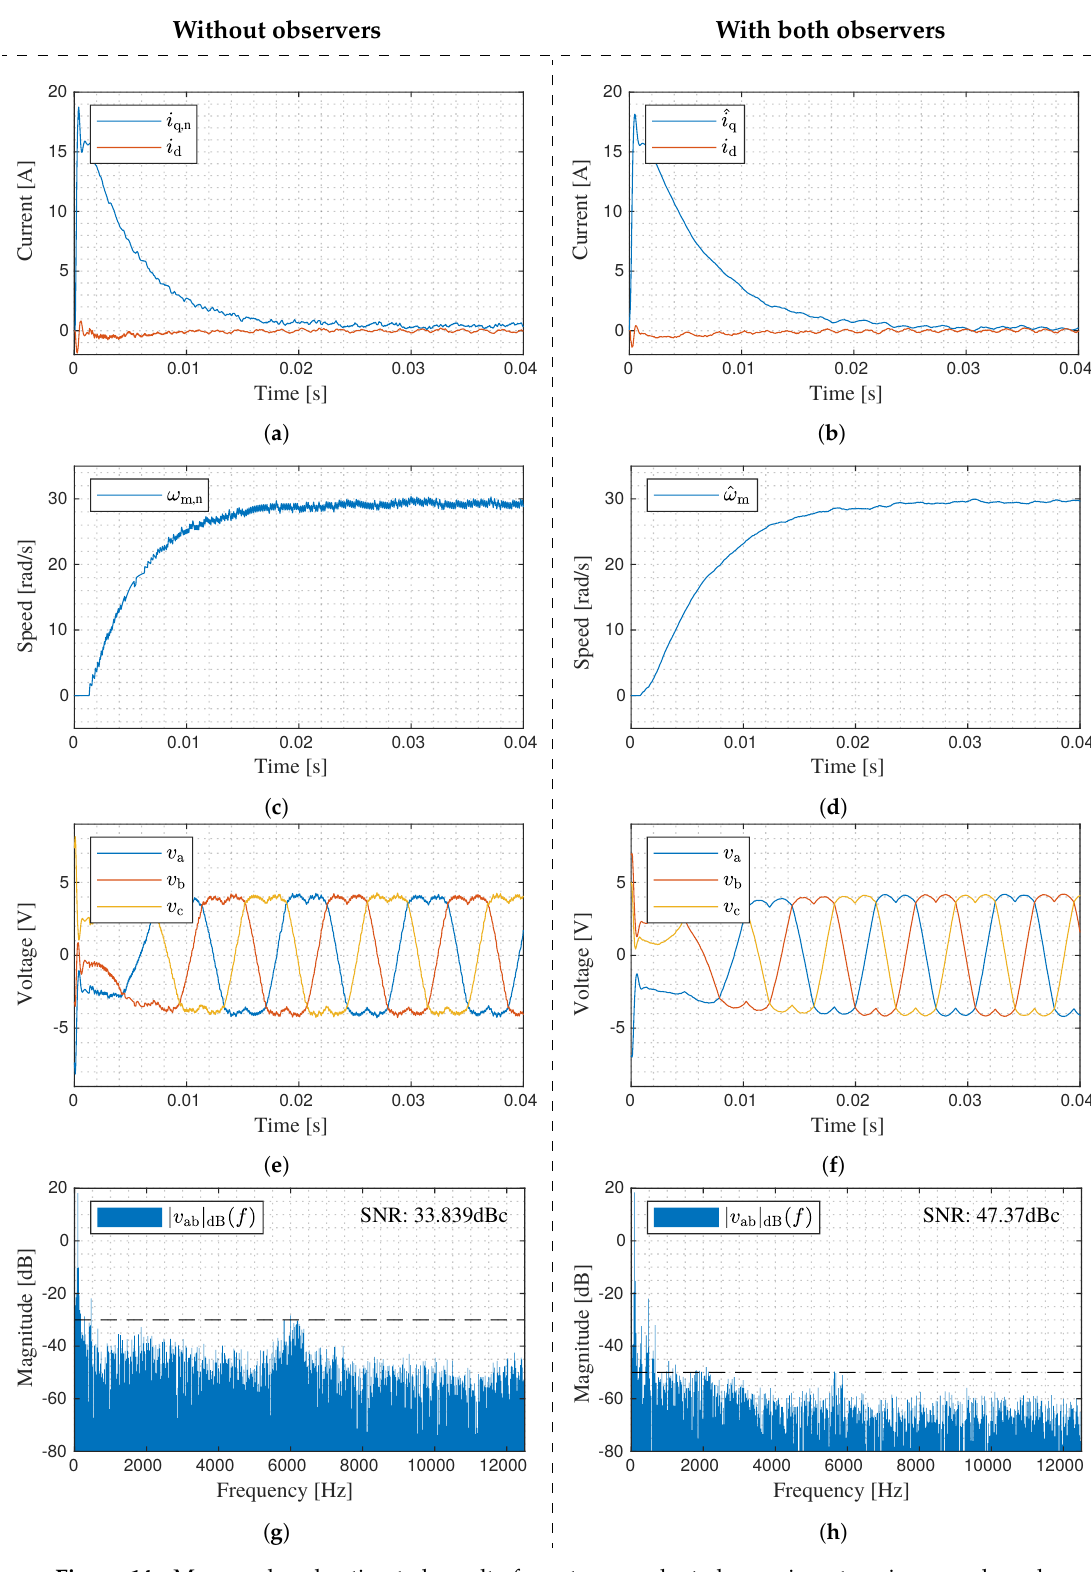
Figure 14. Measured and estimated results from two conducted experiments using speed mode with a single step in speed reference with zero load—without observer ( a , c , e , g ) and with both the novel angle and speed and the Kalman/Luenberger observers ( b , d , f , h ). Both speed estimations ω m,n and ˆ ω m are filtered with the same low-pass filter including a 3dB bandwidth of 200Hz for better performance